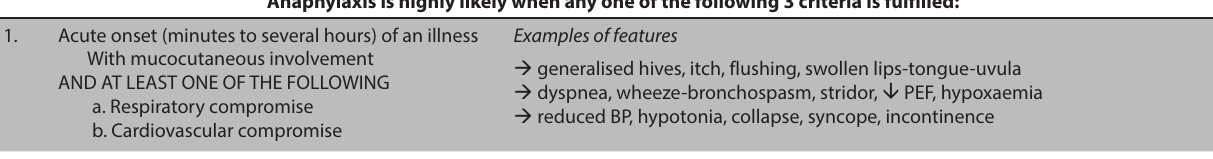
Anaphylaxis is highly likely when any one of the following 3 criteria is fulfilled: